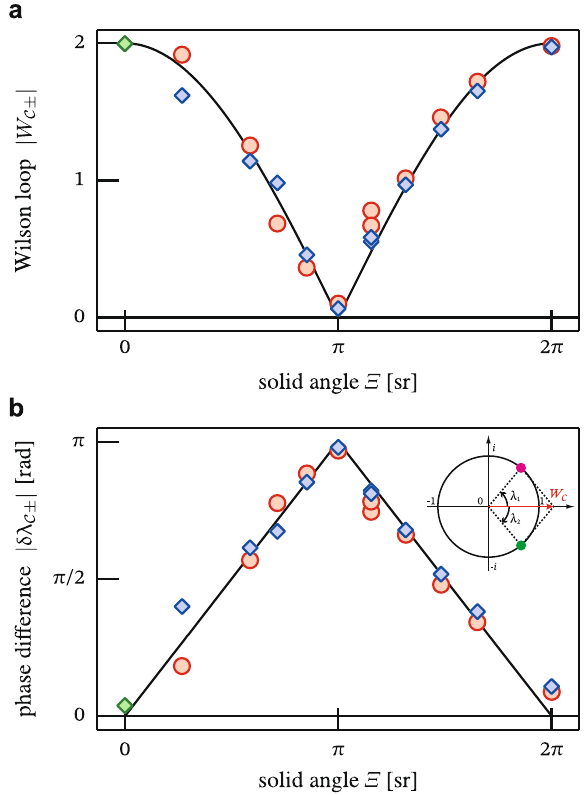
Fig. 4 Wilson loop. a j W C , blue diamonds) and j for forward ( W C ± þ reverse ( W C , red circles) ramps are plotted along with theory (solid (cid:3) curve). At Ξ = 0 ( θ 2 = π /2), the circular paths reduce to a point, which we trivially measure with T = 0 ms (green diamond). b The phase difference of the eigenvalues of W.-Z phase factor j δλ C j ± obtained from the WL measurement in a , with the same symbols. Inset: In the complex plane, the eigenvalues appear on the unit circle (pink and green points), and sum to W C (red